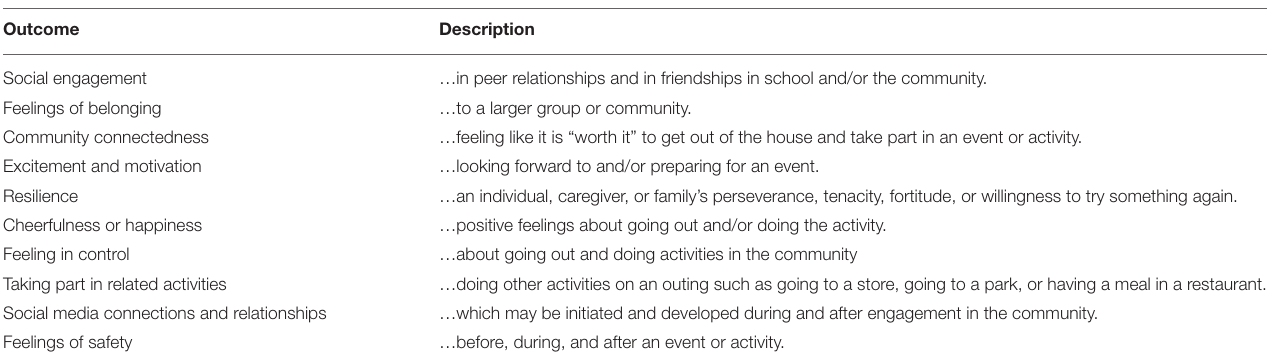
TABLE 4 | Meaningful outcomes to measure in relation to community